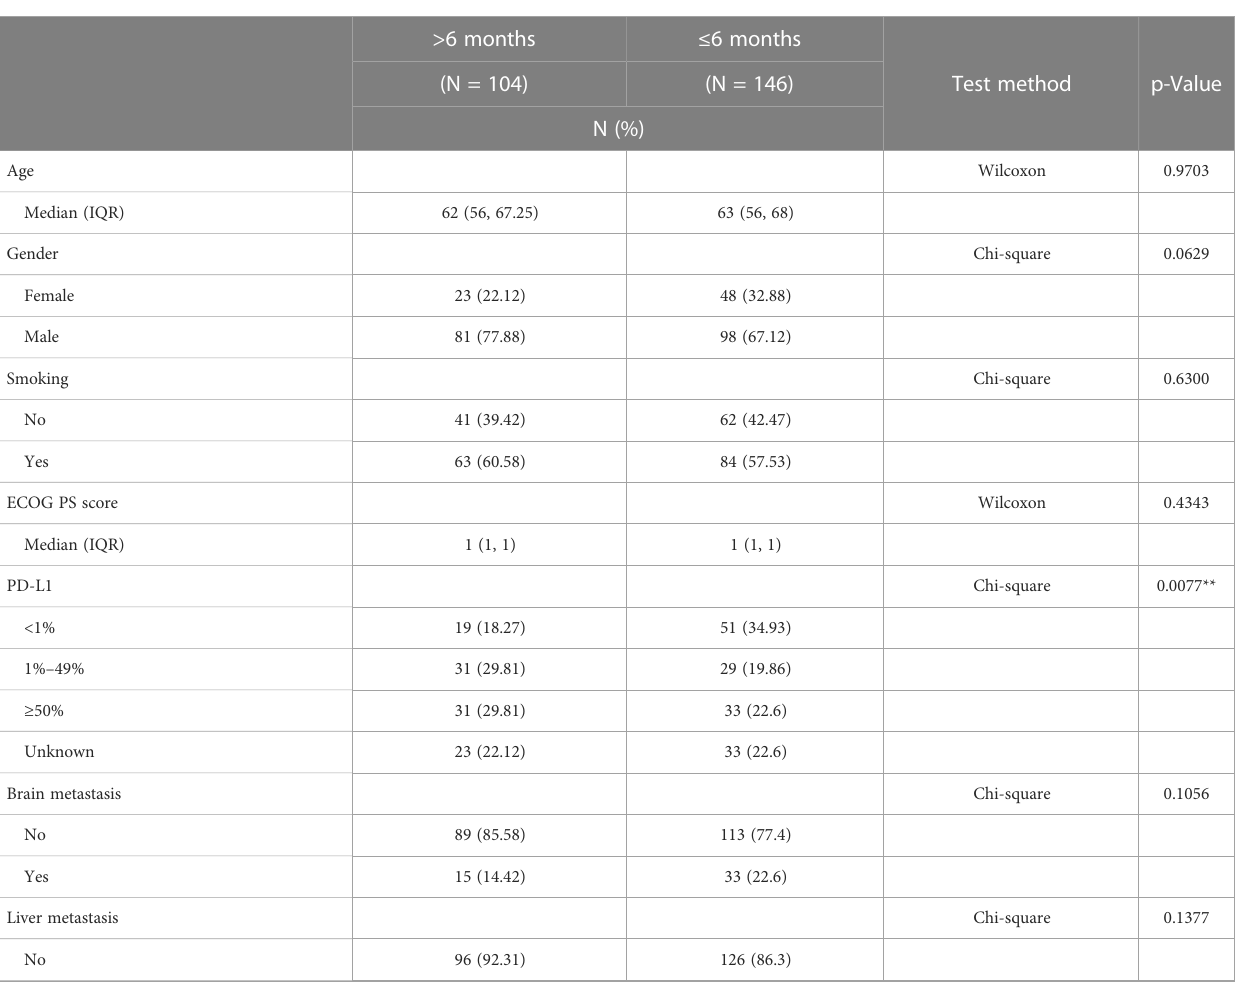
TABLE 1 Clinical features of